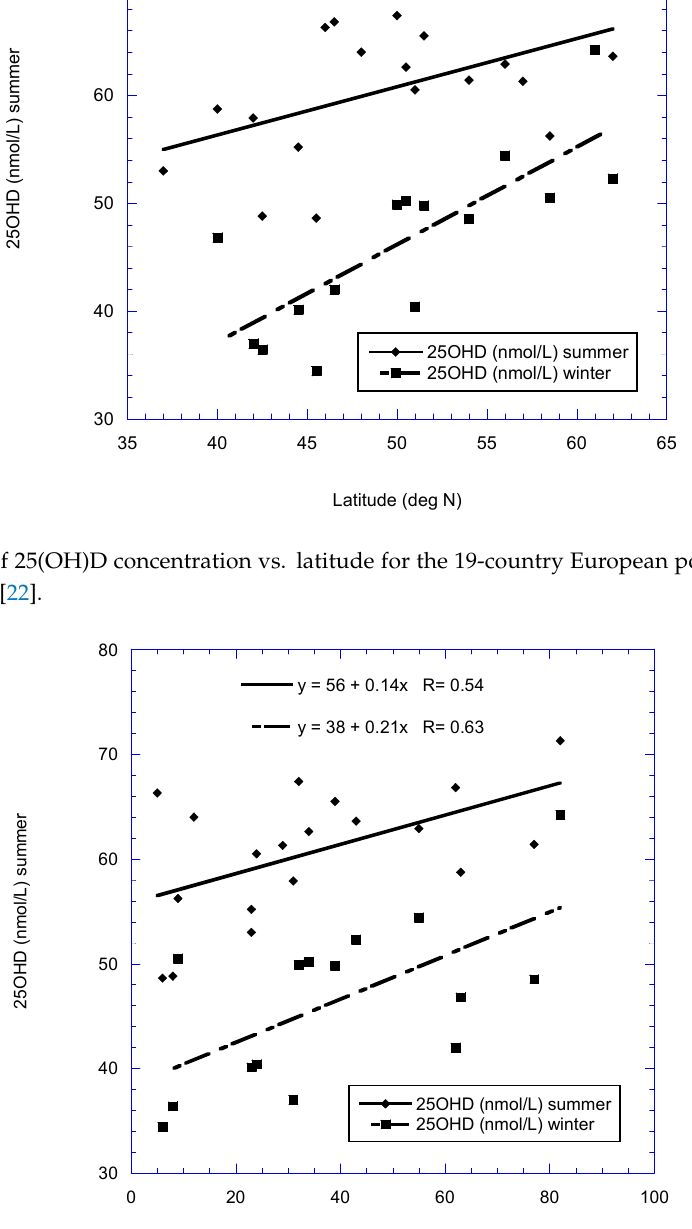
Figure 3. Plot of 25(OH)D concentration vs. dietary supply of ocean fish for the European postmenopausal women’s study [22].